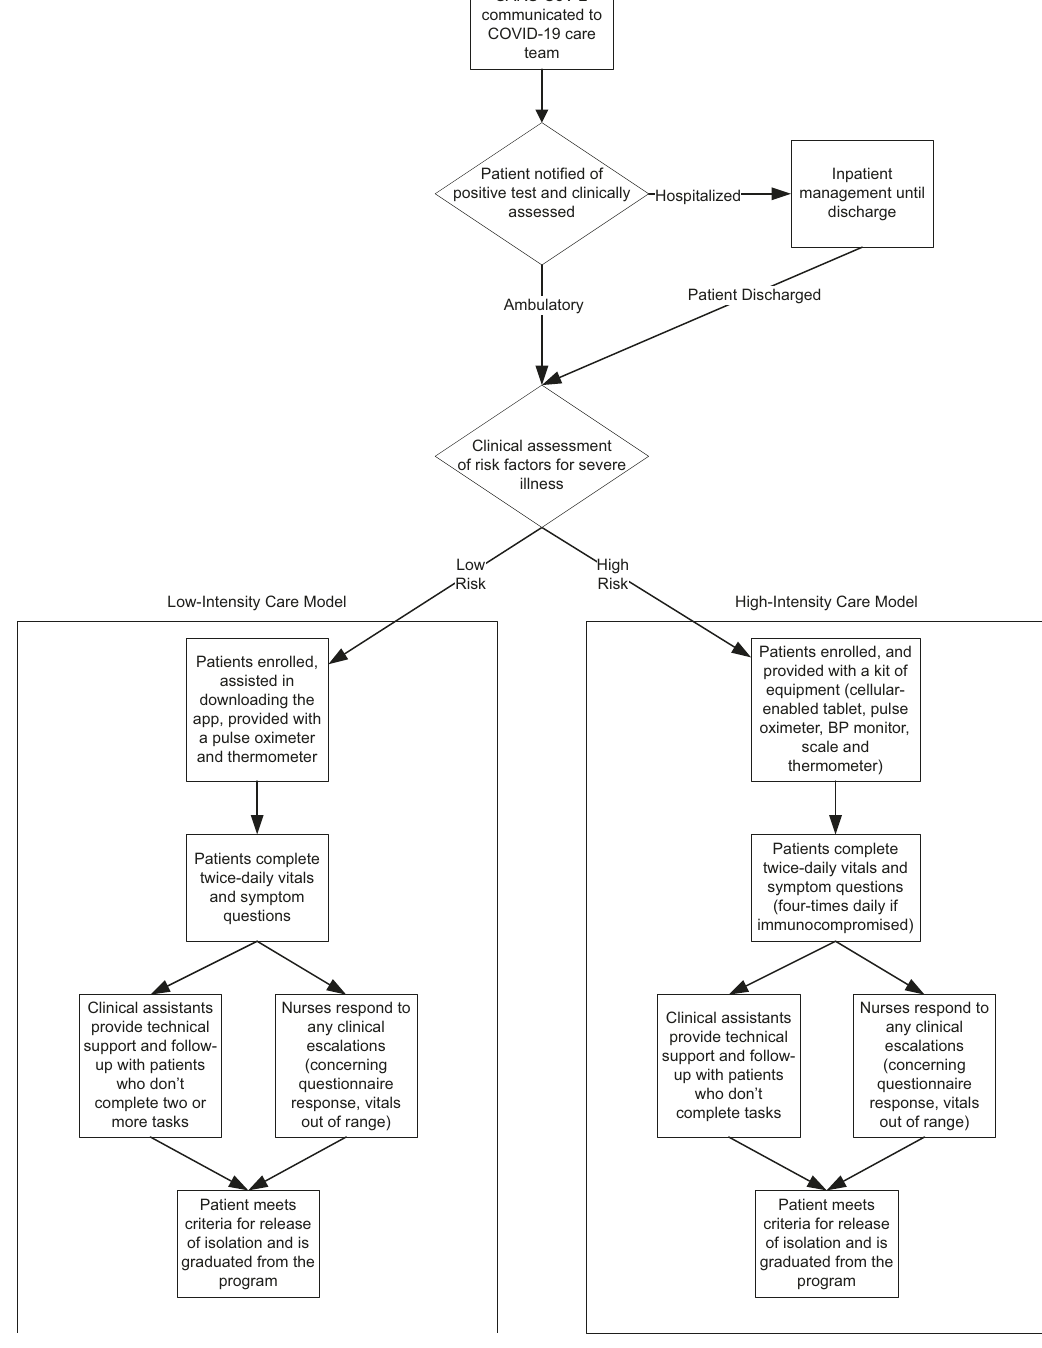
Fig. 1 Clinical work fl ow for patient identi fi cation and eligibility for the COVID-19 RPM care models. Patients at high risk for severe COVID- 19 illness were eligible for the high-intensity care model if they had one or more of the following: age >65 years, diabetes, current smoker, BMI >40, chronic liver disease, chronic lung disease, congestive heart failure, active cancer therapy, bone marrow or solid organ transplant, other immunocompromised state, end-stage renal disease. Additionally, patients were eligible if they were hospitalized for COVID-19 without one of these risk factors, but experienced one of the following: hospital length of stay ≥ 7 days, ICU admission, cardiac complications, need for mechanical ventilation or dialysis, need for oxygen supplementation at discharge, and receipt of remdesivir upon